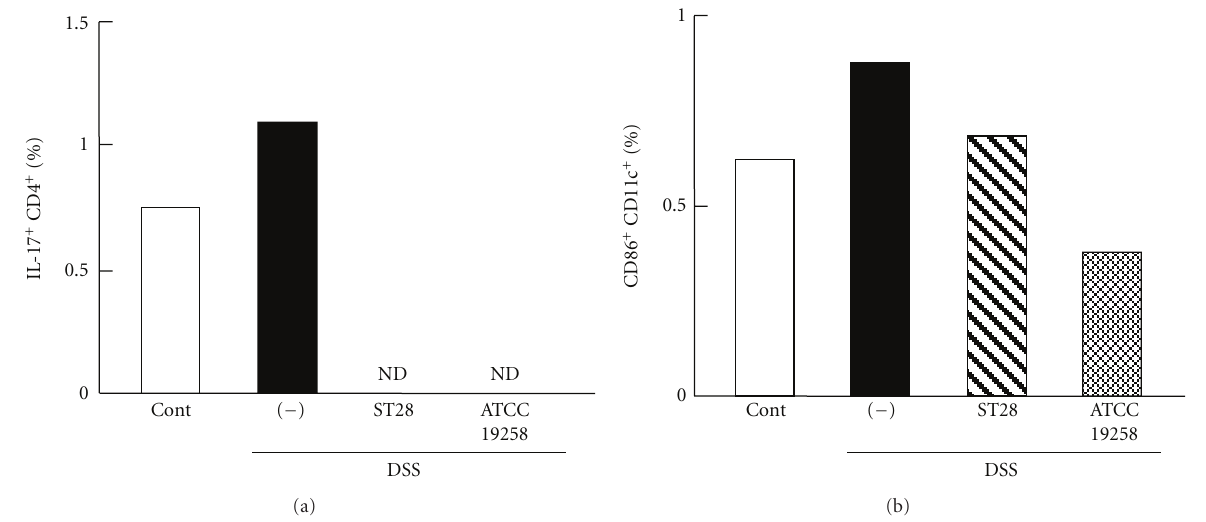
Figure 4: E ff ects of S. thermophilus ST28 on percentages of Th17 (a) and inflammatory DC (b) in LPLs from DSS-induced colitis mice. (a) After the experiments described in Figure 3, LPLs from DSS-induced mice orally administered ST28 or ATCC 19258 were incubated with phorbol-12-myristate-13-acetate, ionomycin, and brefeldin A and applied to flow cytometry to measure intracellular IL-17. (b) Separately, flow cytometric analysis of surface marker CD86 was performed using freshly prepared LPLs. LPLs from untreated DSS-induced colitis mice ( − ) and healthy control mice (Cont) were also assayed. ND, not